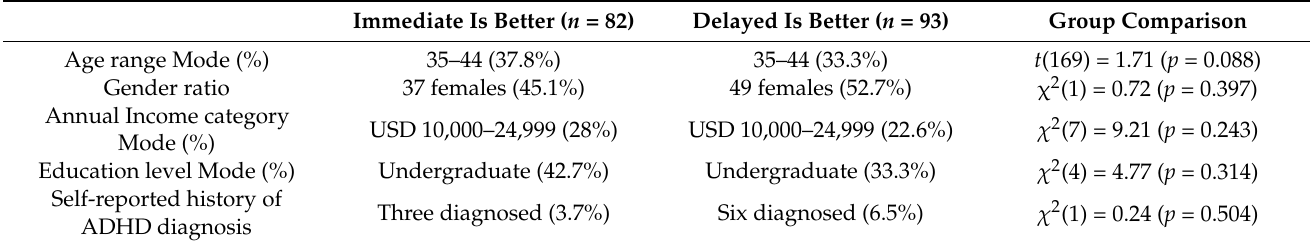
Table 1. Demographic and clinical characteristics by optimality condition